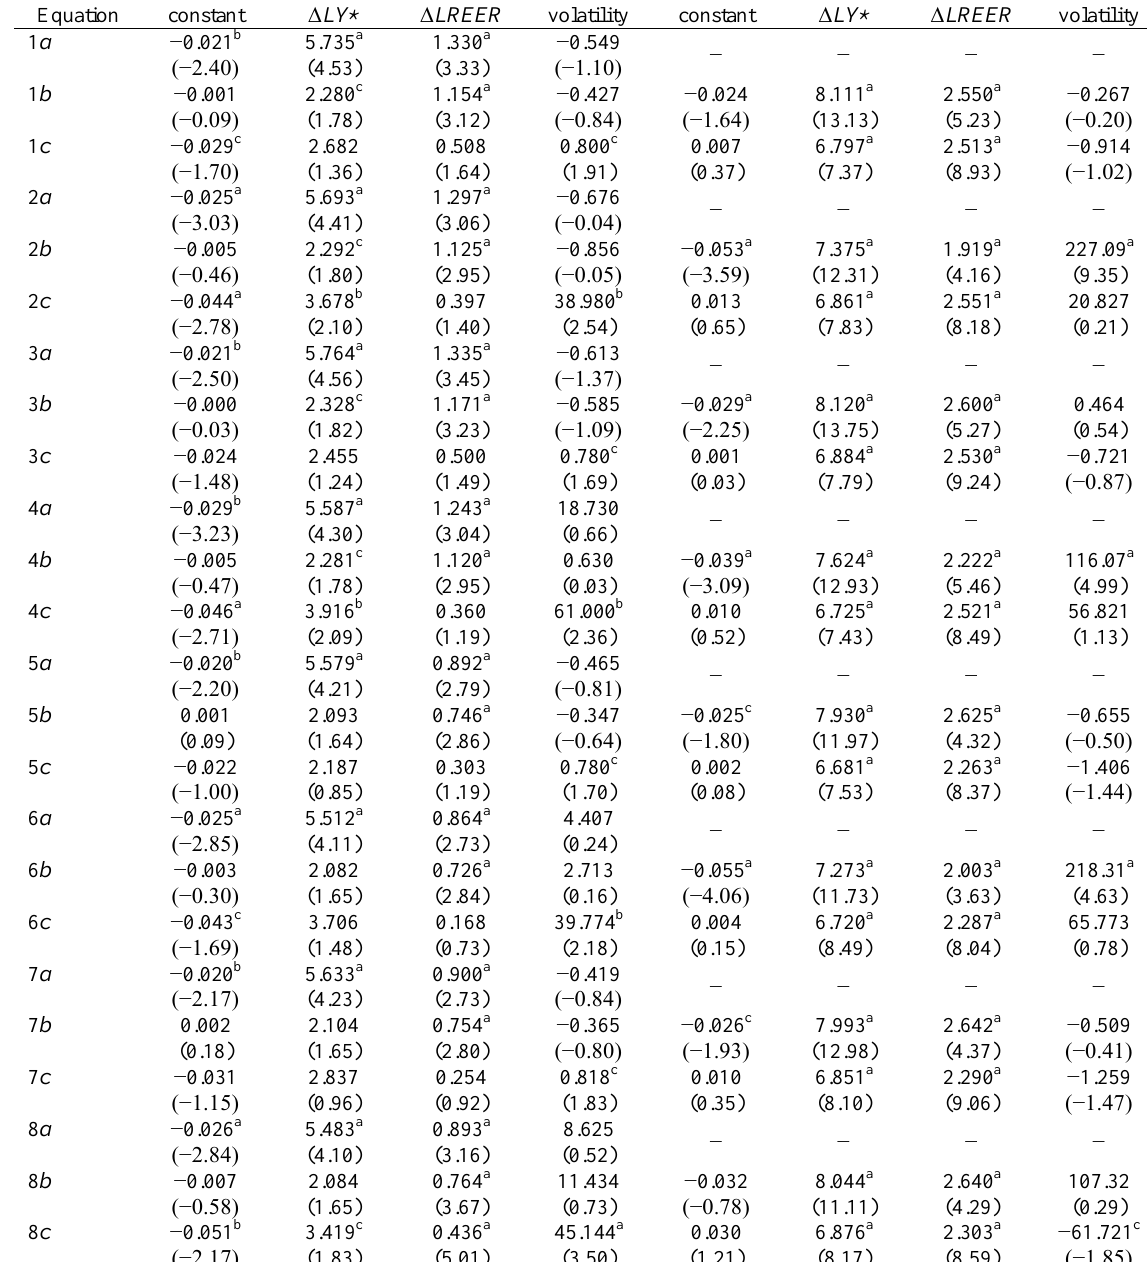
Table 8 : Exports and exchange rate volatility: